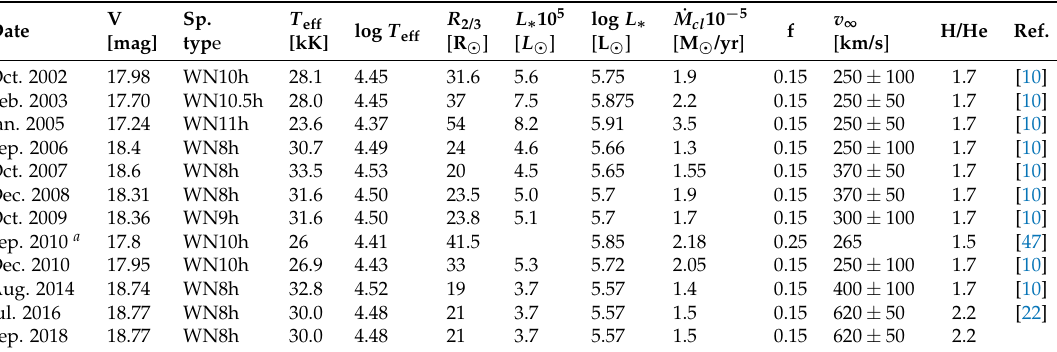
Table 5. Derived properties of Romano’s star at the moments corresponding to different acquired spectra. H/He indicates the hydrogen number fraction relative to helium, f is the filling factor of the stellar wind. Details of modeling may be found in